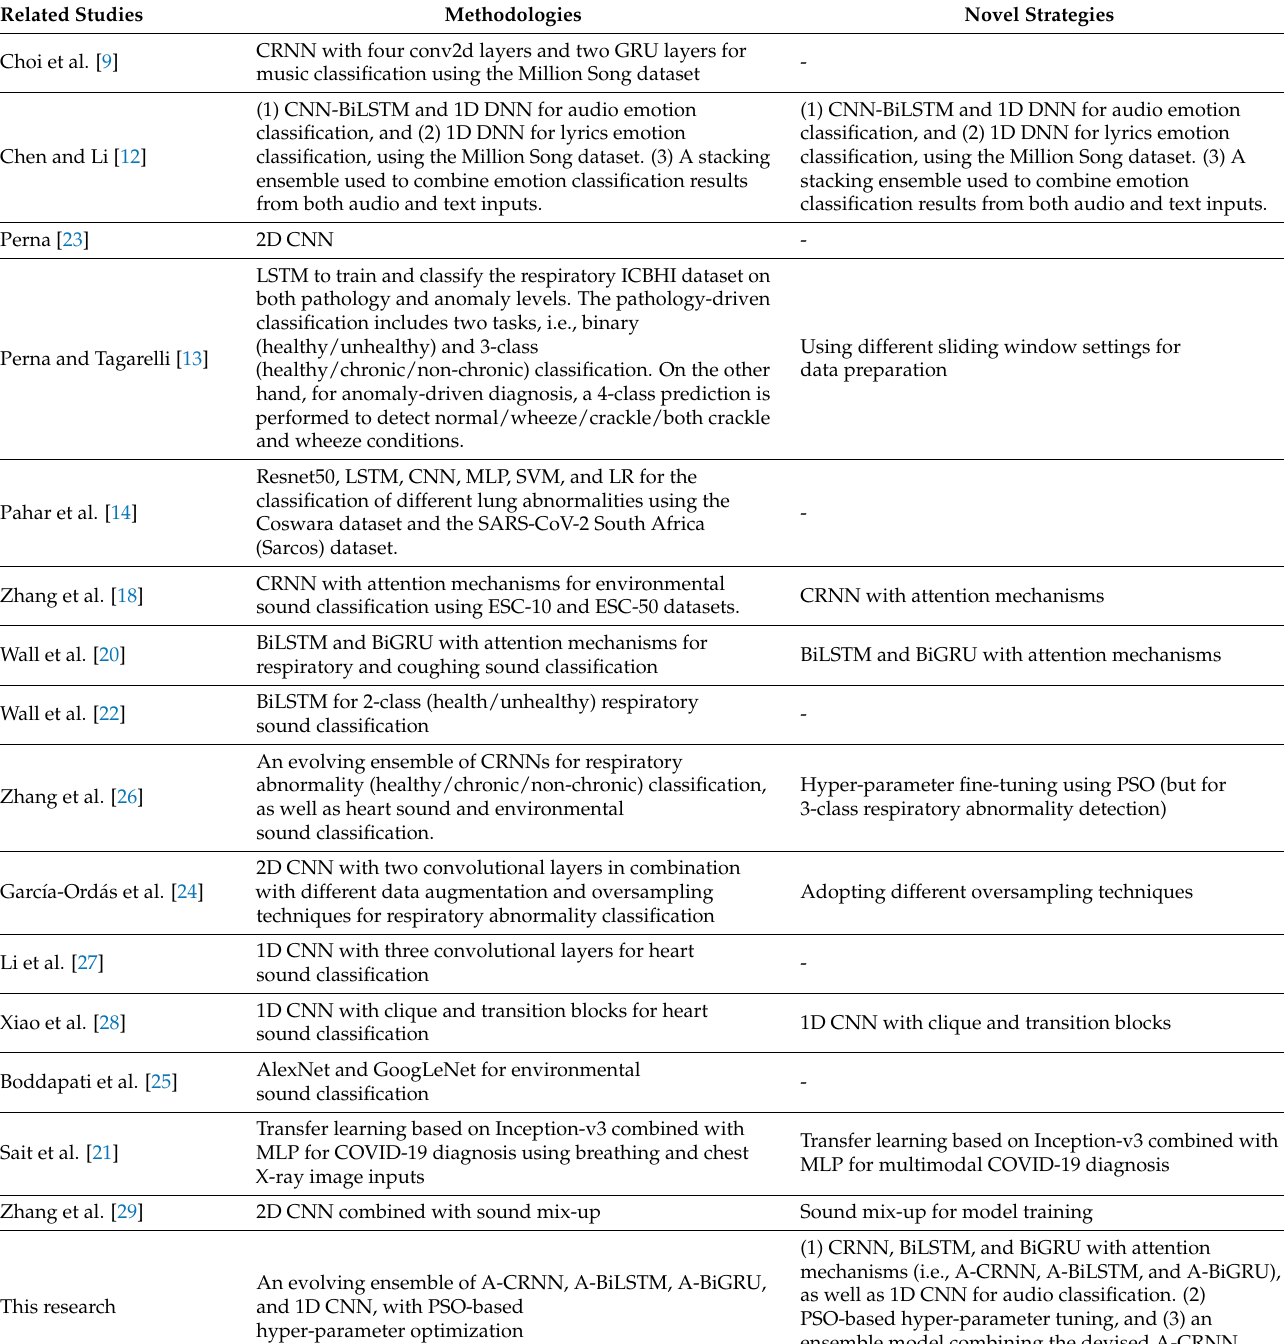
Table 1. The summary of existing studies for sound